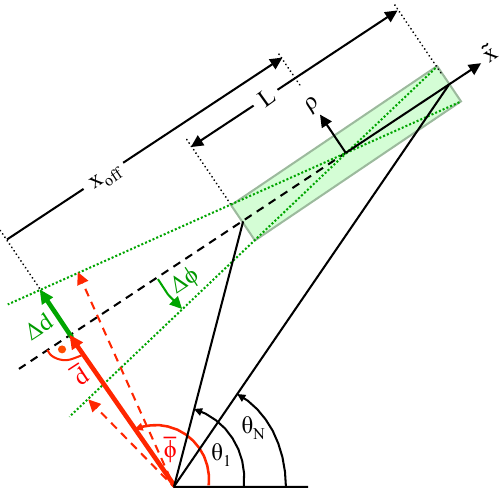
Figure 3. Dependency between ∆ d , ∆ φ and geometric parameters.